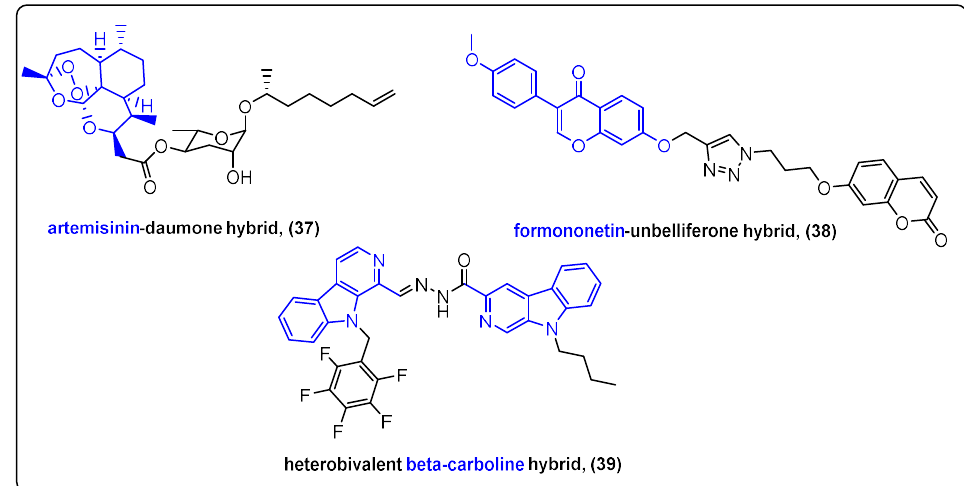
Figure 12. Hybrids incorporating two natural